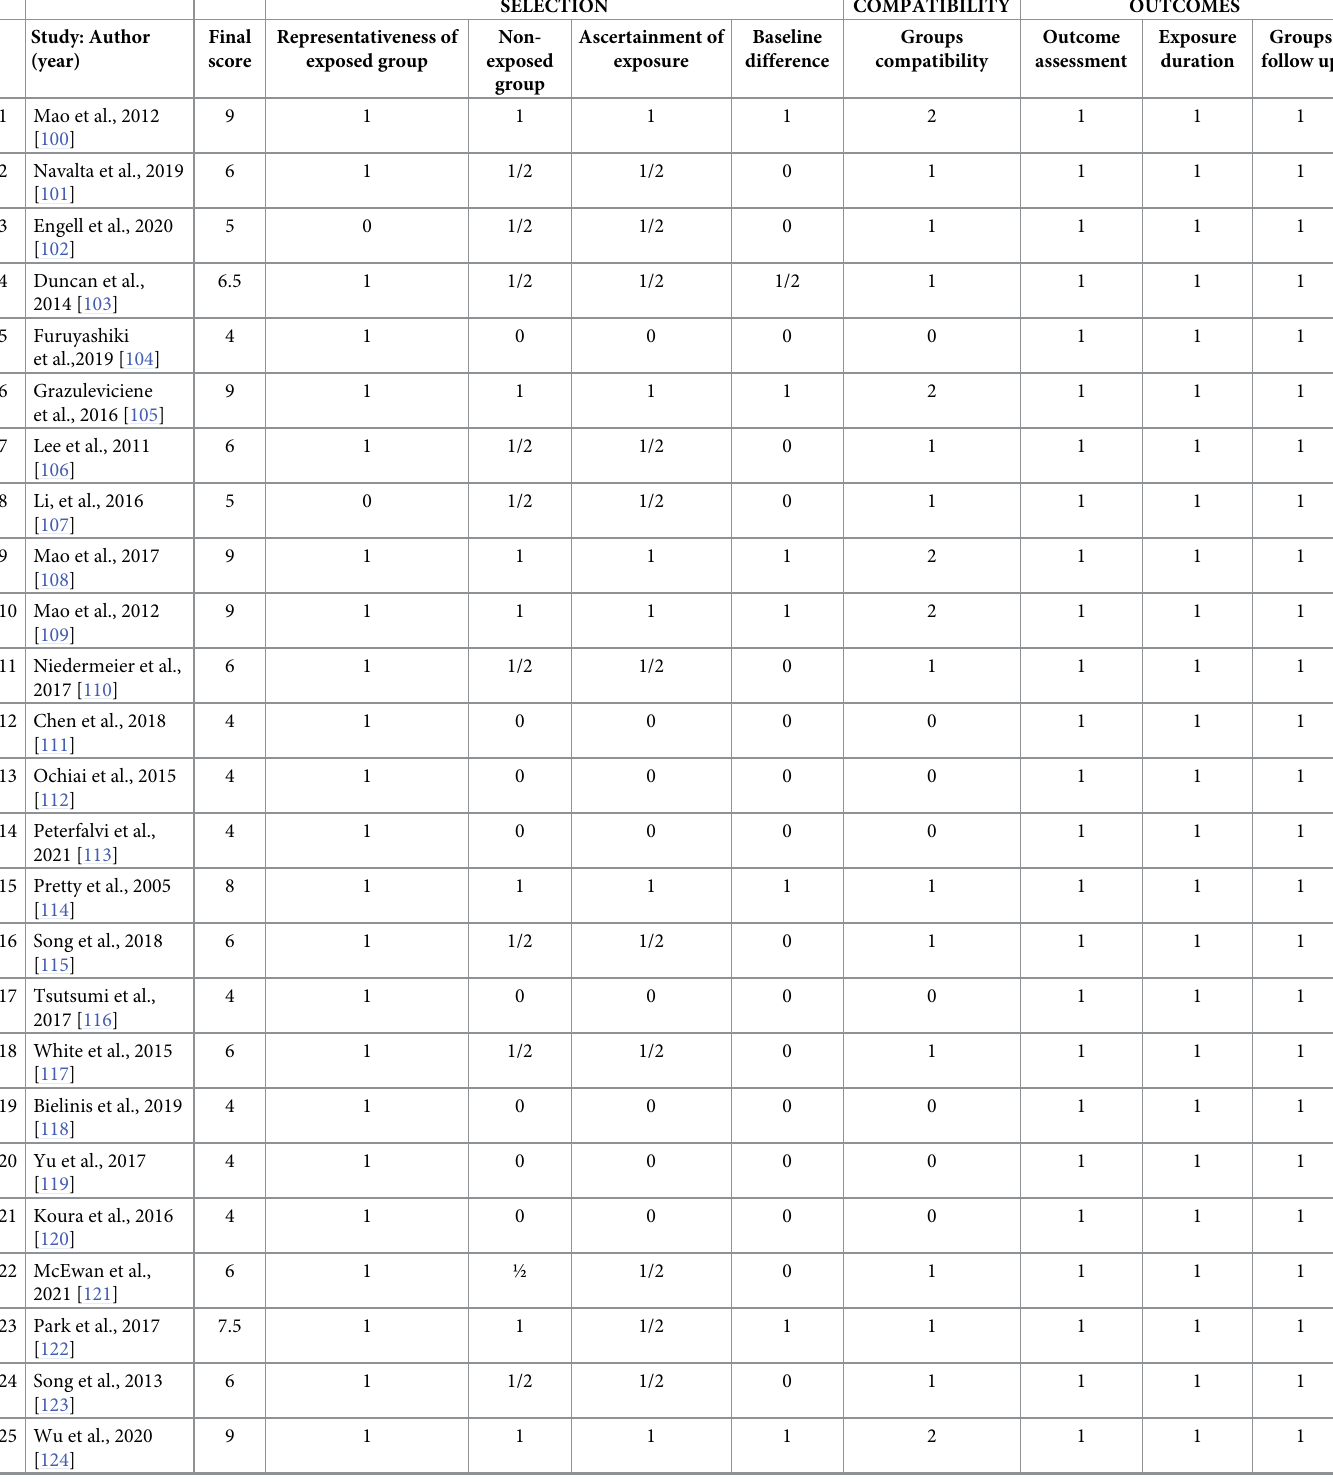
Table 2. Risk of bias assessment of included studies using a Modified version of the Newcastle–Ottawa